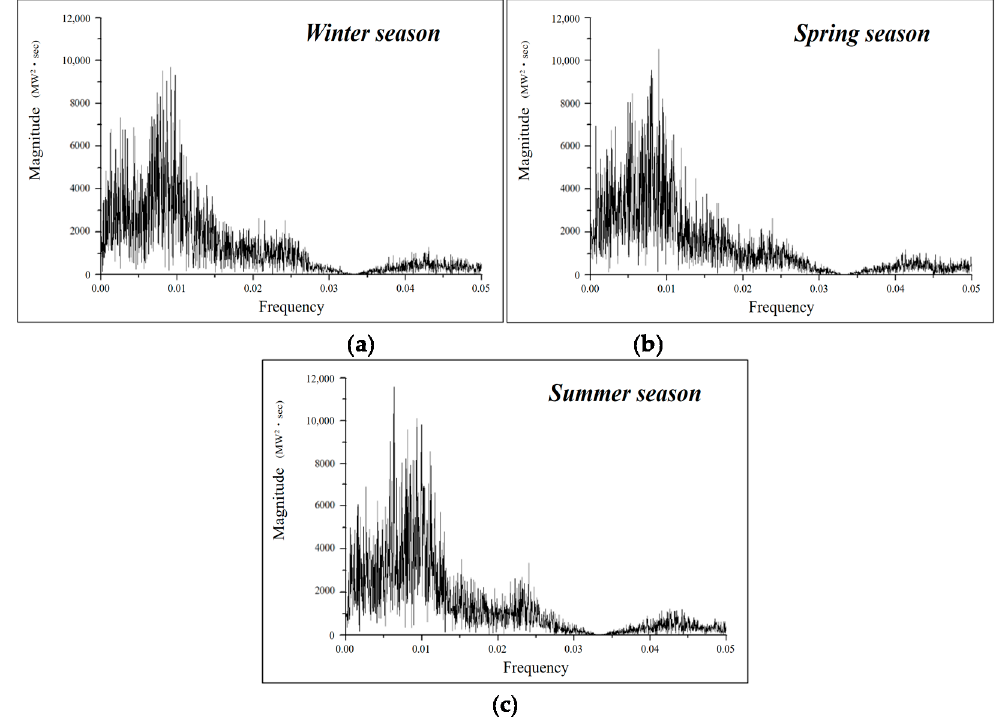
Figure 3. Frequency spectrum of fluctuation for total steel industrial loads: ( a ) Winter season; ( b ) Spring season; ( c ) Summer season.